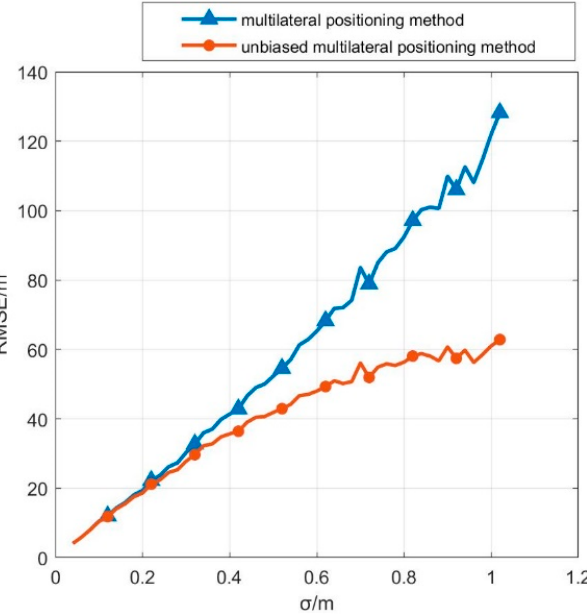
Figure 2. Comparison of root mean square error between multilateral positioning method and unbiased multilateral positioning method.